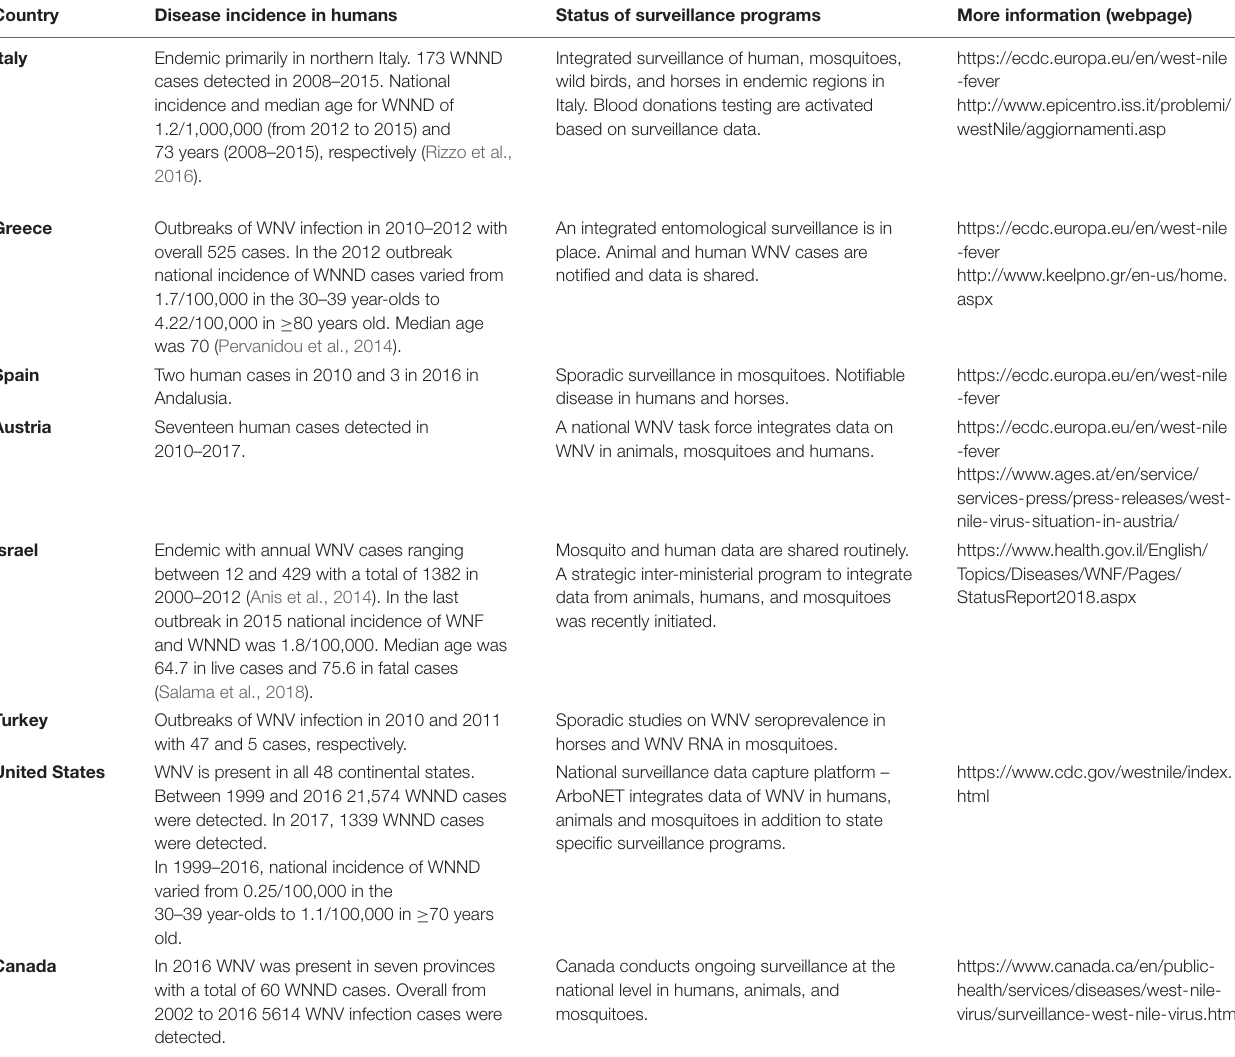
TABLE 1 | West Nile Virus (WNV) incidence in humans and surveillance programs in selected